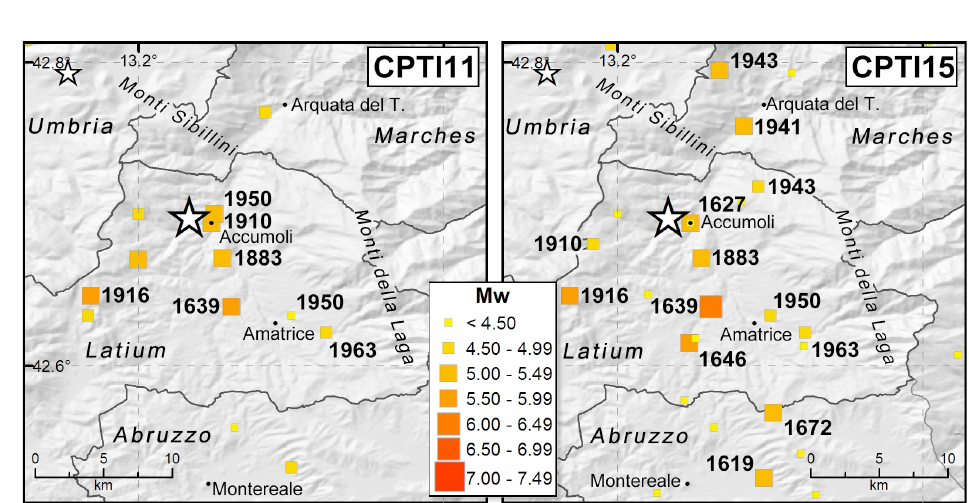
Figure 1: Main seismicity of the Central Apennines according to (a) CPTI11 and (b) CPTI15. Stars indicate the sequence’s main shocks (August 24, 2016, Mw 6.0 and 5.4)